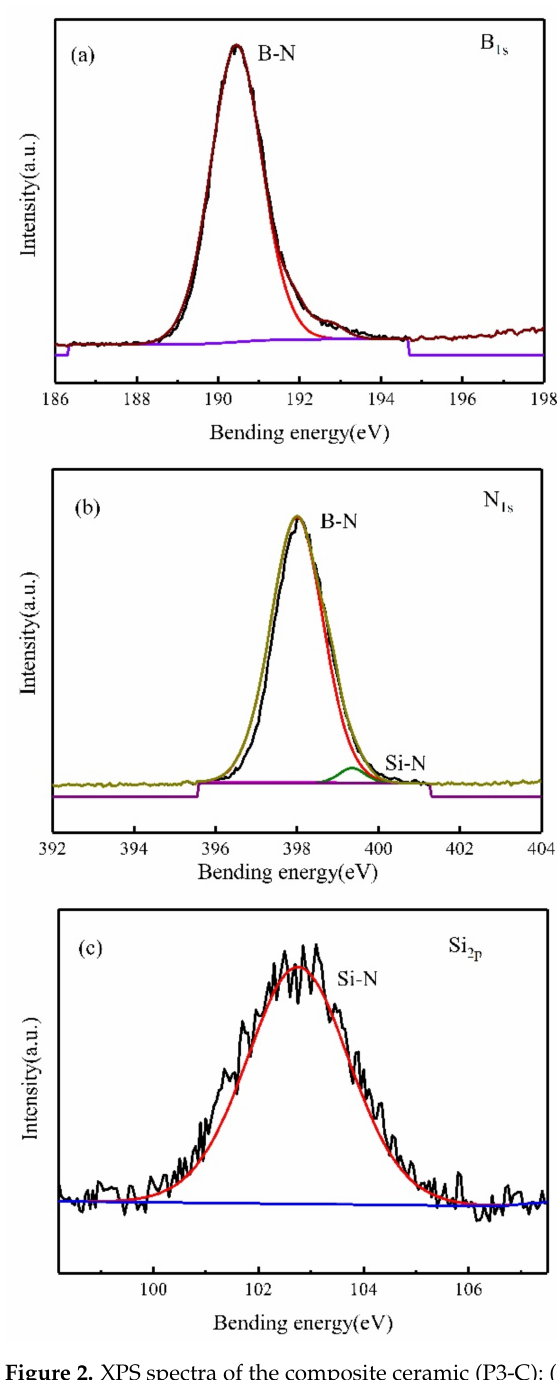
Figure 2. XPS spectra of the composite ceramic (P3-C): ( a ) B 1s ; ( b ) N 1s ; ( c ) Si 2p